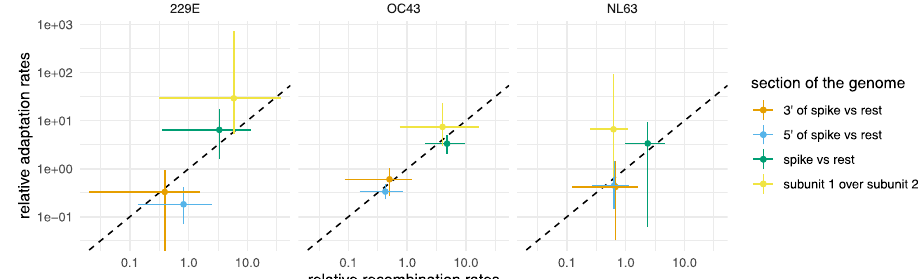
Fig. 3 Comparison of recombination rates with rates of adaptation on different parts of the genomes of seasonal human coronaviruses 229E, OC43, and NL63. Association between estimated relative recombination rate ( x -axis) and relative adaptation rate ( y -axis) for three different seasonal human coronaviruses: 229E, OC43, and NL63. These estimates are shown for different parts of the genome, indicated by the different colors. These results from two different types of analysis: one using spike only (subunit 1 over subunit 2, shown in yellow) and one using the full genome (shown in orange, blue, and green). The rate ratios denote the rate on a part of the genome divided by the average rate on the two other parts of the genome. The error bars of the recombination rates ( x -axis) denote the upper and lower bounds of the 95% HPD intervals of the estimates of relative recombination rates. The error bars of the rates of adaptation are computed using 100 bootstrapped outgroups and alignments when computing the rates of adaptation. Source data are provided as a Source Data fi le.